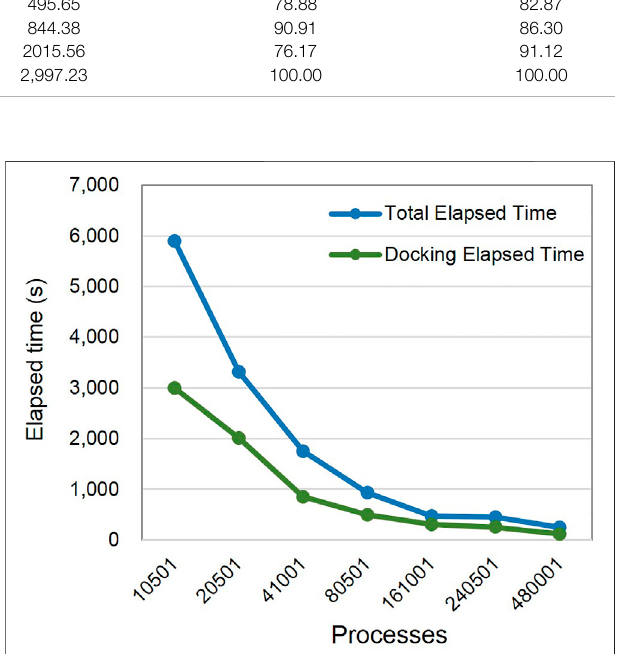
FIGURE 14 | Scaling results on Sunway